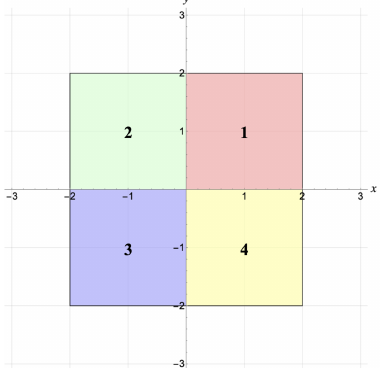
Figure 2 . The chaotic region B . The region B is divided into the four